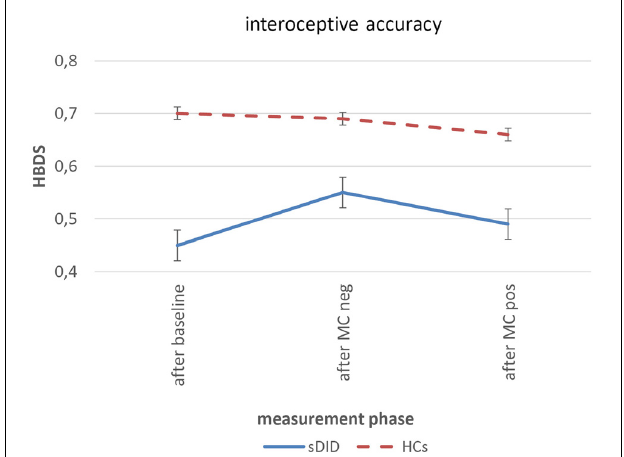
FIGURE 3 | Heartbeat detection score over the course of the experiment. Within-group differences: linear mixed models, between-group differences: ANOVAs controlling for initial value of HBDS. sDID, patients with subthreshold Dissociative Identity Disorder; HCs, healthy controls; MC, mirror-confrontation; neg, negative (negative cognitive accompaniment); pos, positive (positive cognitive accompaniment); HBDS, heartbeat detection